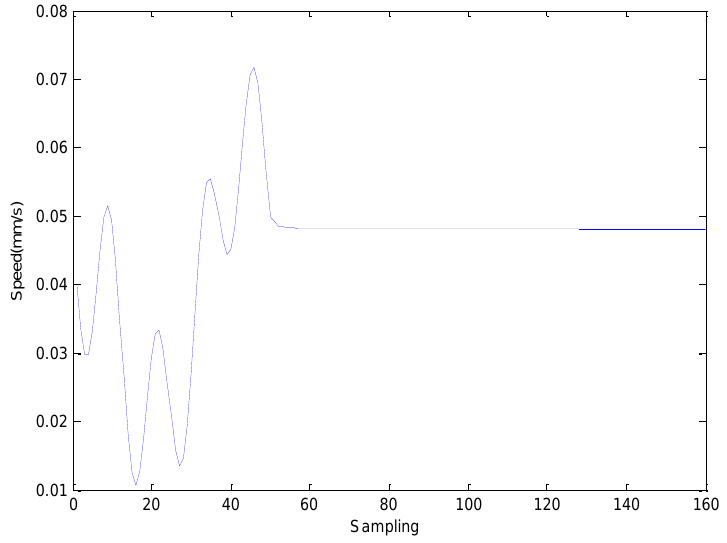
Figure 4. A typical control process (the set speed = 0.05).